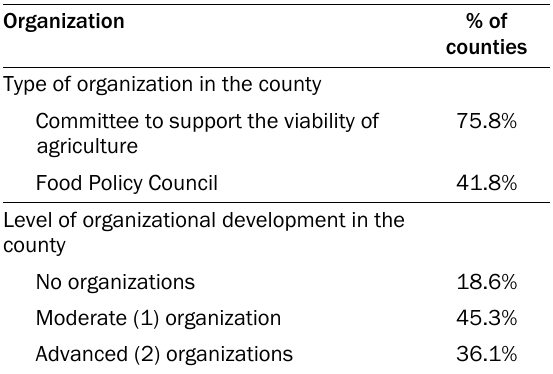
Table 1. Organizations and